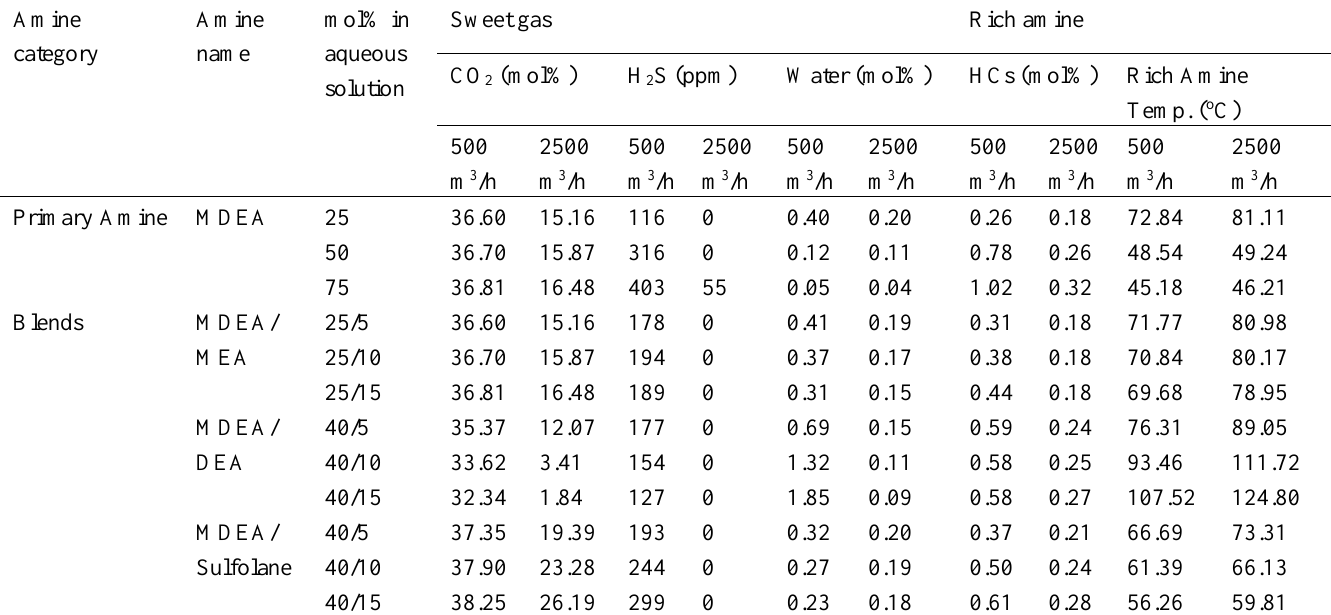
Summary of the simulated